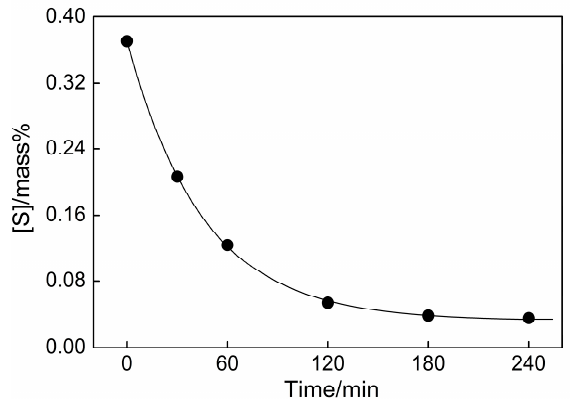
Figure 3. The change of sulfur content in the metal with time. Table 1. Experimental data after equilibration.